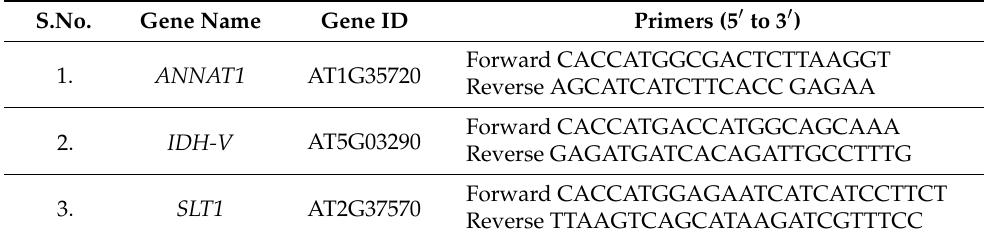
Table 1. Coding DNA Sequence (CDS) of the selected putative interactors were amplified using gene specific primer